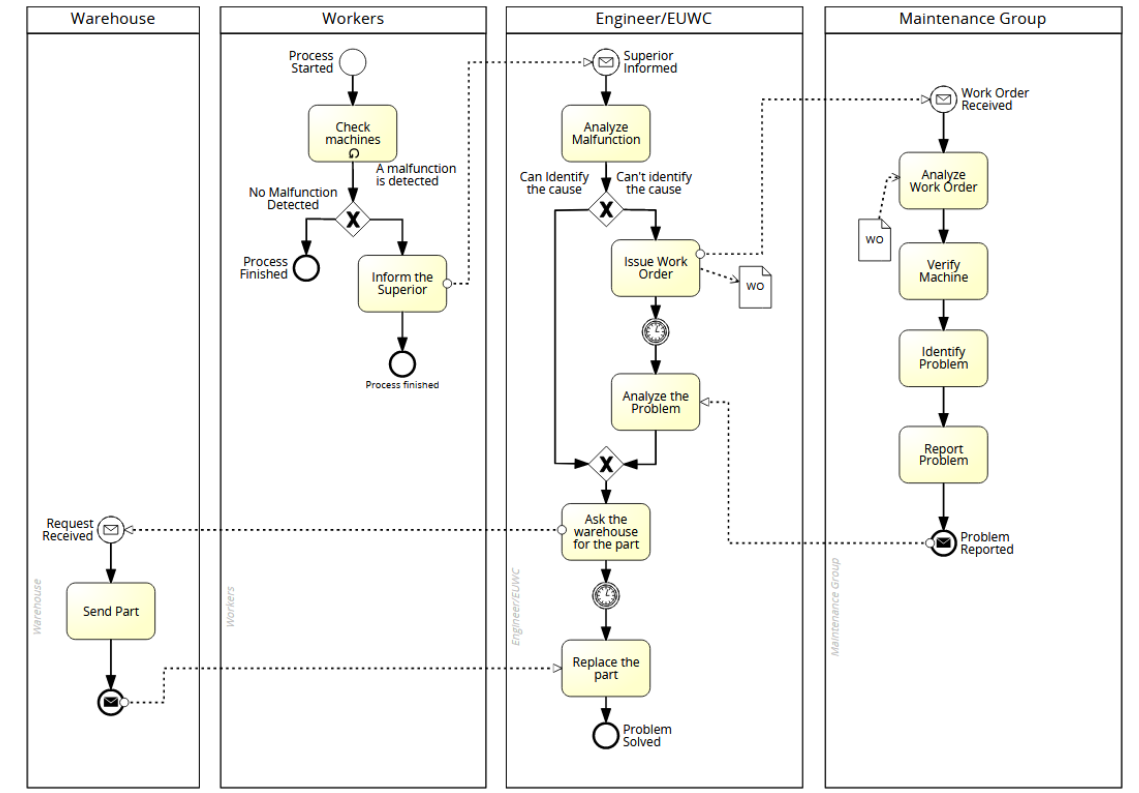
Figure A1. Preventive maintenance action plan.